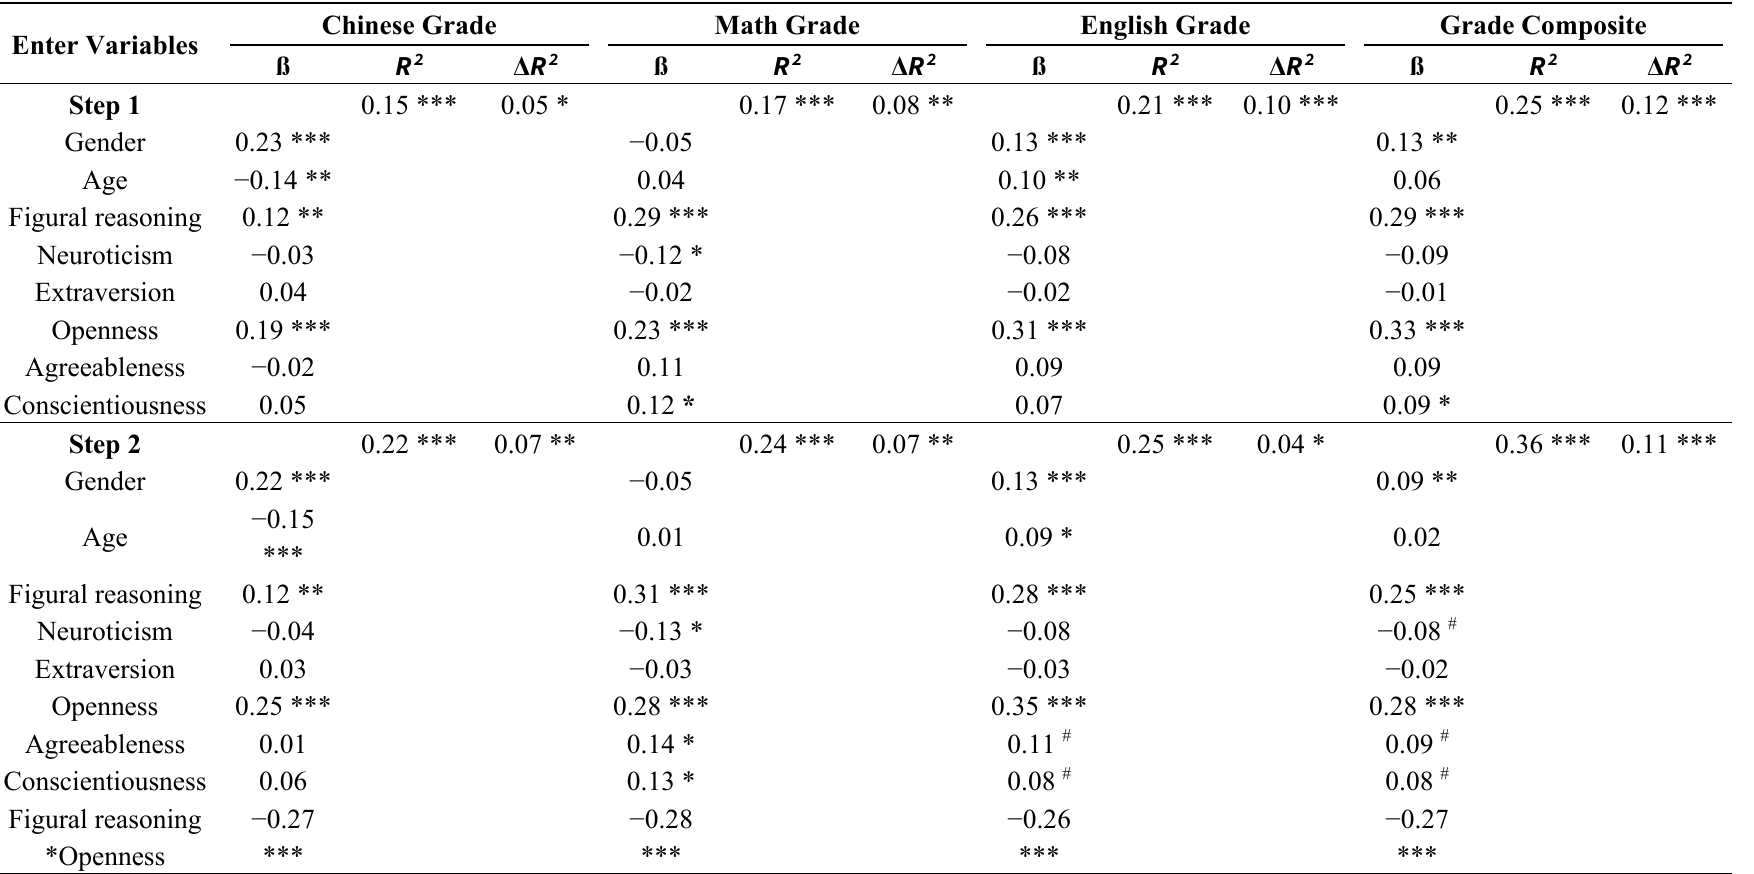
Table 3. Prediction of scholastic performance in Chinese, Math, and English: results from hierarchical latent regression models. Enter Variables